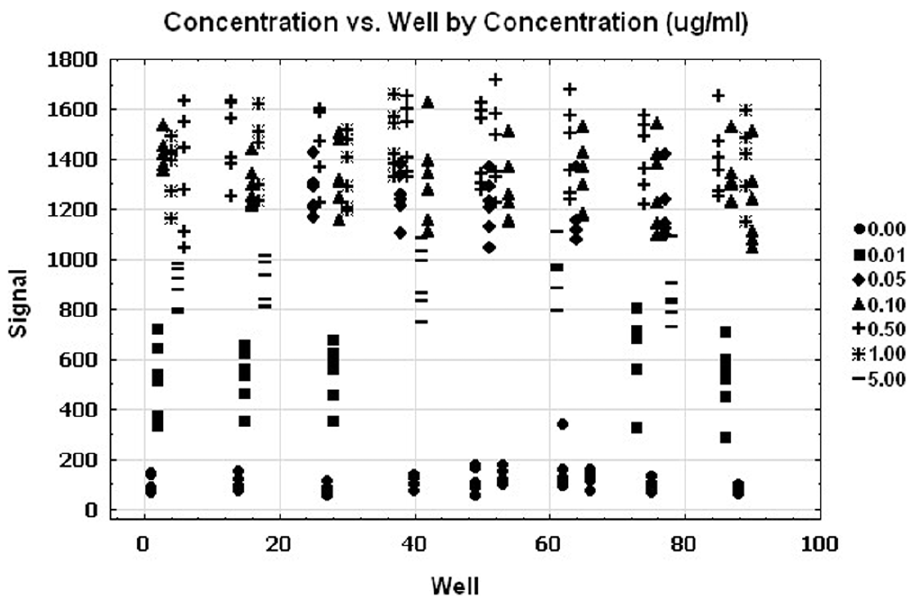
Figure 4. Spatial uniformity assessment of the GnRHR pharmacoperone assay. The signals are plotted against the well number. The wells are ordered by the rows and columns in order to explore any patterns of the edge, drift effect and other systematic source of variability.